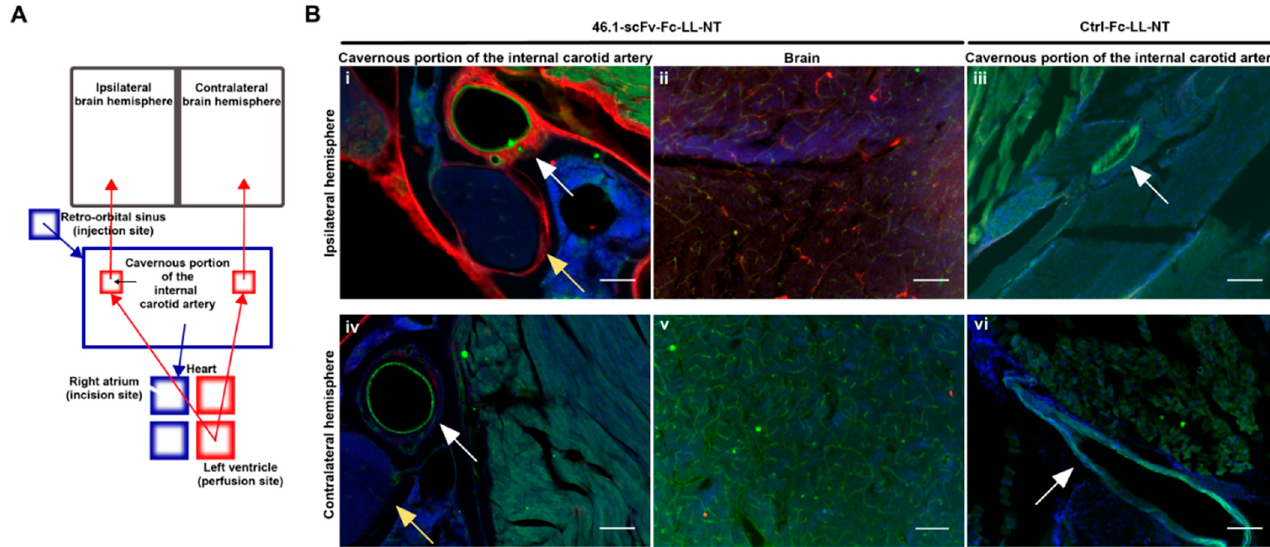
Figure 4. 46.1-scFv-Fc-LL-NT accumulates in the cavernous sinus and brain after retro-orbital injection. ( A ) Compartmental scheme of the surgery procedure and fluid flows. Blue arrows represent the venous blood flow, red arrows the arterial flow, the black arrow represents the putative reverse transcytosis. Mice were injected with 46.1-scFv-Fc-LL-NT or Ctrl-Fc-LL-NT (20 mg/kg) in the retro-orbital sinus and immediately whole body perfused as an incision was made in the right atrium to disconnect the lung circulation. ( B ) Coronal sections of the skull at the level of the cavernous sinus were labeled for the fusion proteins with fluorescent anti-rabbit Fc AlexaFluor555 antibody (red), internal carotid artery endothelial cells (green, white arrows), and blood vessels in brain were visualized with CD31 and secondary AlexaFluor488-conjugated antibody (green). N. trigeminus (yellow arrows), nuclei (blue). Scale bar, 100 µm. Concentration gradients between venous blood in the cavernous sinus and arterial blood in the internal carotid artery have been hypothesized to be a driving force of